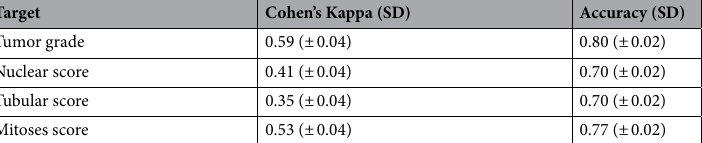
Table 3. Agreement and accuracy of model versus pathologists grading, overall as well as split by nuclear pleomorphism, tubular differentiation and mitotic count. Results are shown on the test set ( n = 686). The standard deviation (SD) was calculated using bootstrapping.